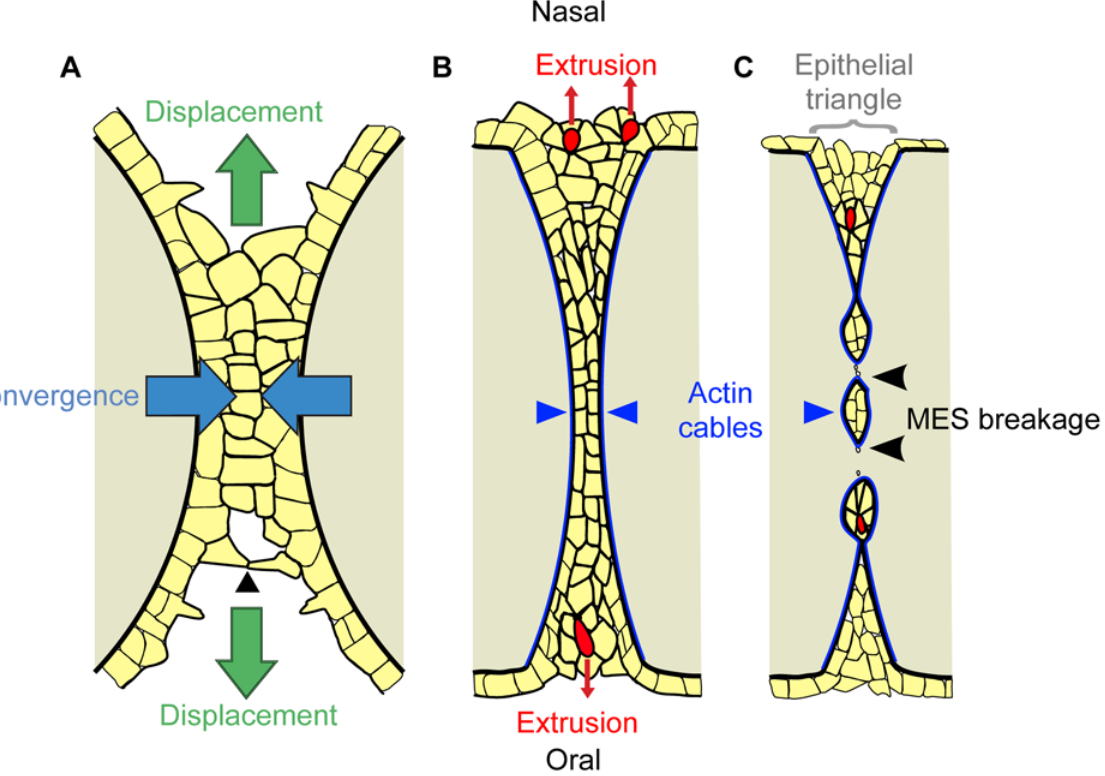
Fig 7. Model of cellular dynamics in palatal fusion. (A – C) Schematic diagram of frontal sections of the MES at progressive stages of palatal fusion. Yellow represents epithelium, tan represents mesenchyme, and red represents extruding cells. (A) Palatal fusion is initiated by cellular protrusions reaching across to form junctions with the apposing shelf (arrowhead). Convergence of the multilayered epithelium toward the midline (blue arrows) is concurrent with oral and nasal displacement of MES epithelium (green arrows). (B) Multicellular actin cables (dark blue) form laterally around the seam as it intercalates to a common MES structure. Formation of multicellular rosettes and cell extrusion (red cells) releases MES cells to the oral and nasal surfaces of the palate. (C) The multicellular actin cables contract, contributing to MES breakage (black arrowheads), and cell extrusion events in the epithelial triangles (grey bracket) continue to remove epithelial cells from the